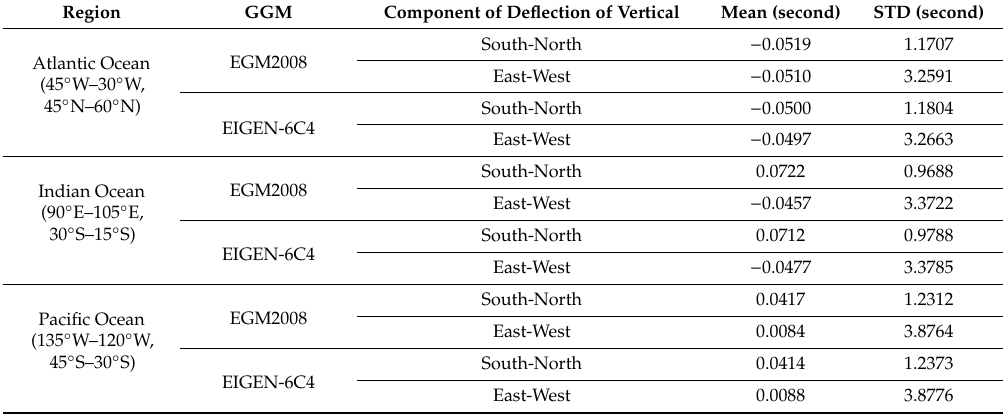
Table 2. Statistics of di ff erences between vertical deflections from the HY-2A and gravity field models. Region GGM Component of Deflection of Vertical Mean (second) STD